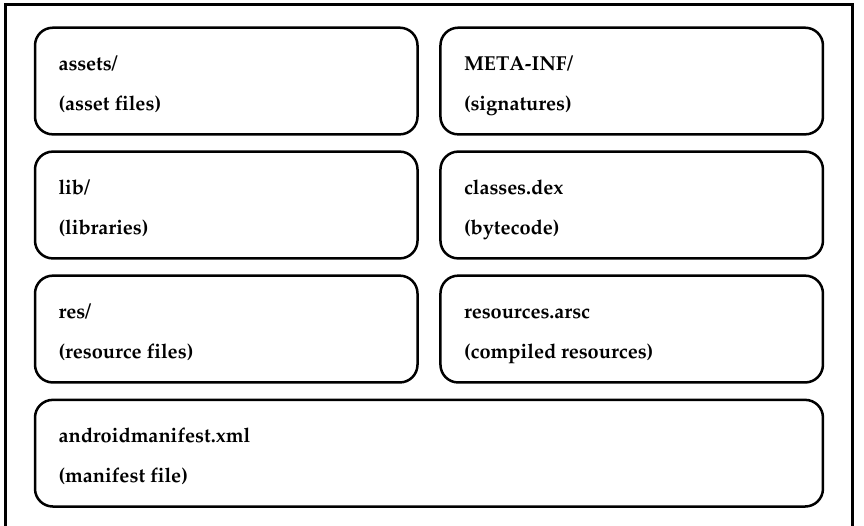
Figure 1. APK file